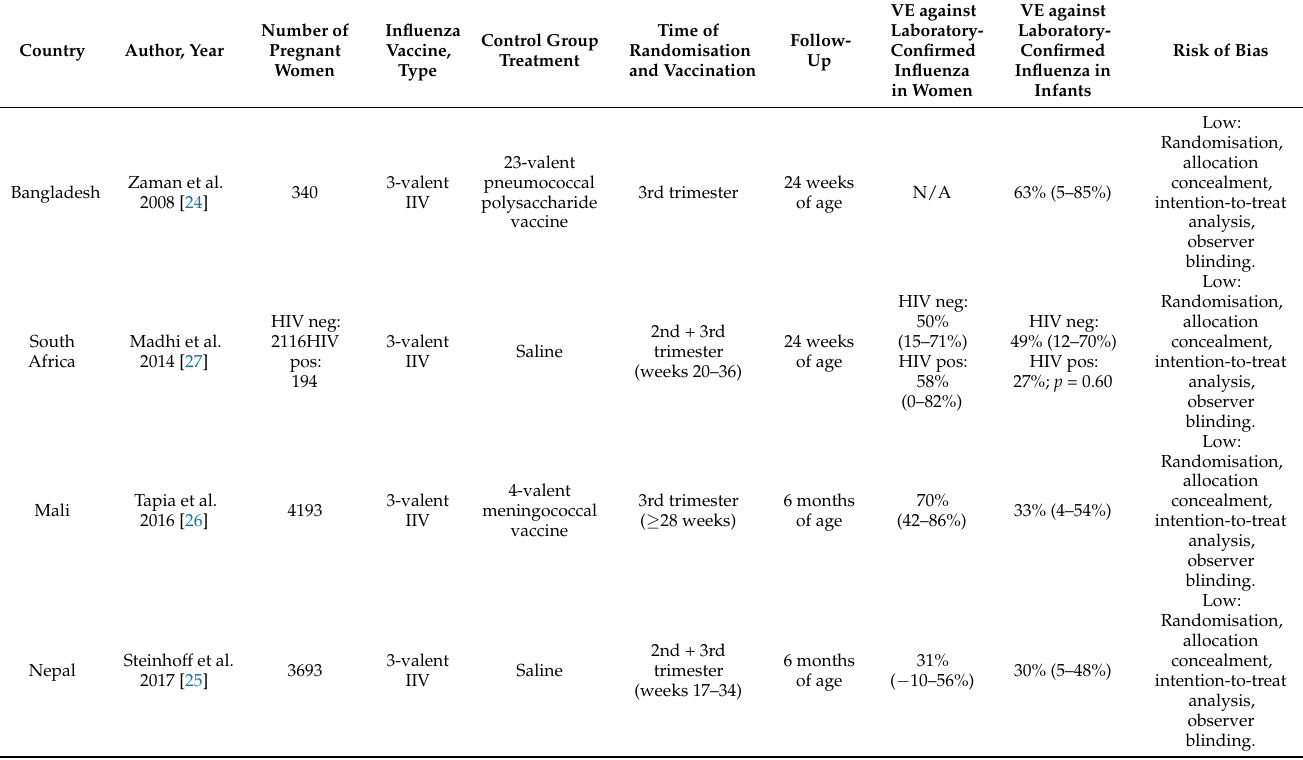
Table 1. Randomised controlled trials of influenza vaccination in